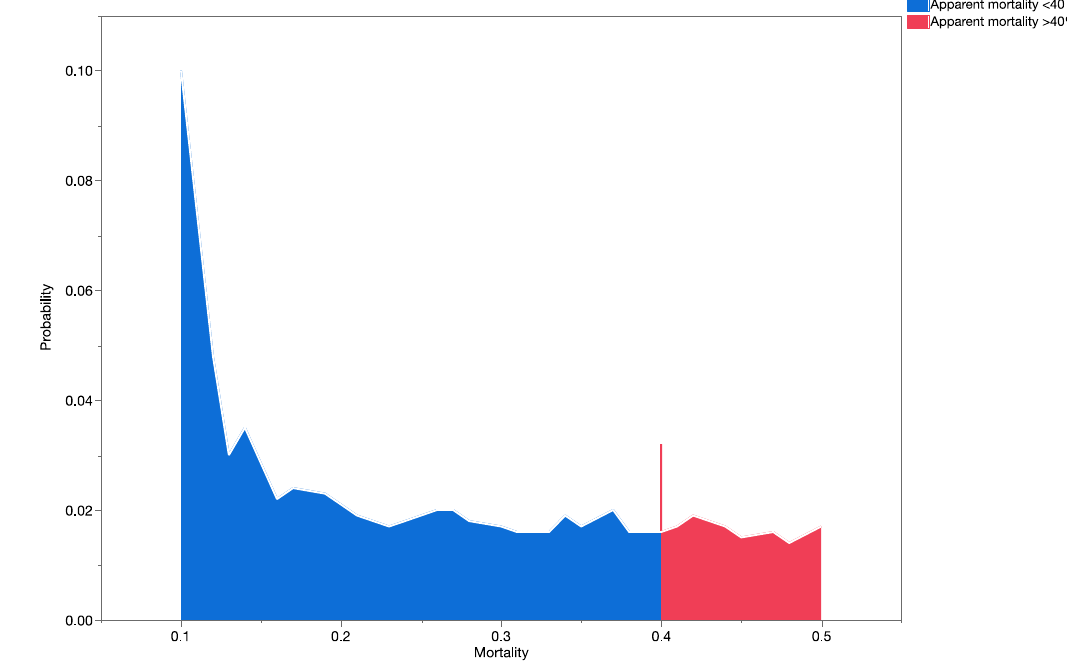
Figure 10. Distribution of all possible values of apparent mortality rate for T. flavoorbitalis , specifically indicating a 28.21% probability that expected parasitism values will rise above 0.40 .